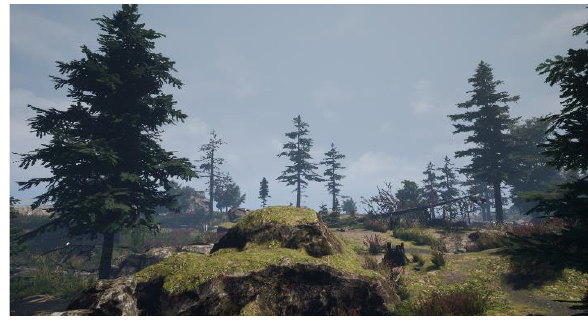
Figure 3. Second virtual scene sample